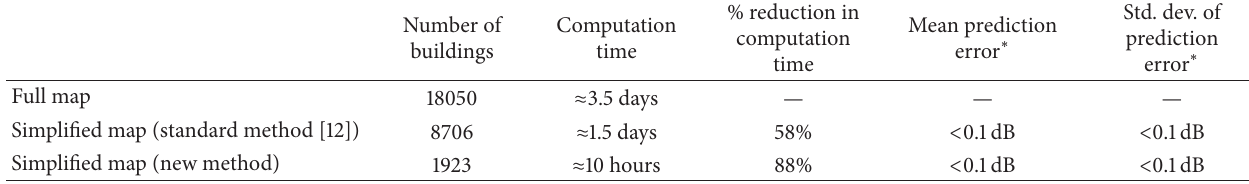
Table 1: Comparison between computation times and simulation results for site A000127C using full map and simplified